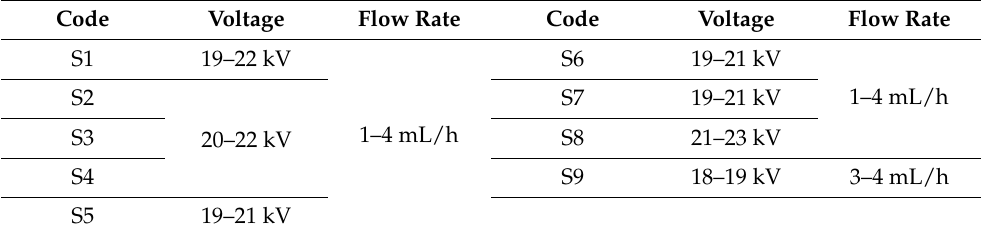
Table 2. Electrospinning process parameters for solutions loaded with bioactive